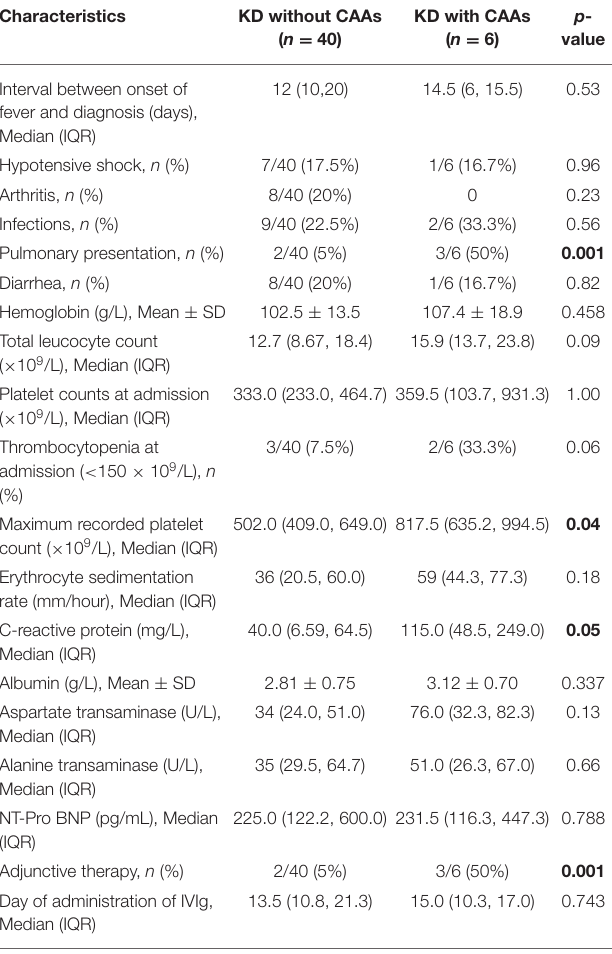
TABLE 4 | Comparison of clinical and laboratory features of patients of Kawasaki disease (KD) with and without coronary artery abnormalities (CAAs). Characteristics KD without CAAs